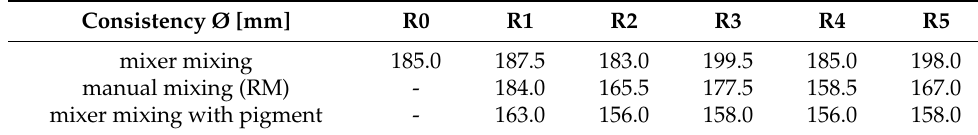
Table 6. Determination of fresh mortar consistency by spilling